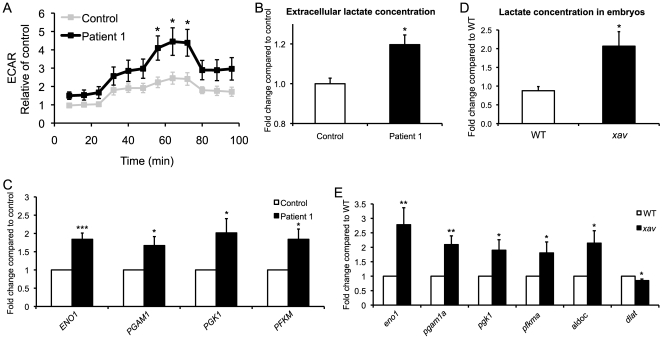
Increased aerobic glycolysis in MADD fibroblasts and xav mutants.
A. ECAR was measured in intact control and MADD Patient 1 fibroblasts under basal conditions, following the addition of the mitochondrial inhibitor oligomycin (0.5 µg/ml), in the presence of the uncoupler CICCP (3 µM) and following the addition of the complex I inhibitor rotenone (100 nM). A trend towards higher ECAR rate was seen under basal conditions, and a significant 2-fold increase was observed after uncoupler CICCP treatment in Patient 1 fibroblasts compared to control. (N = 3 experiments, 7–9 replicates of cells from passage 7–12; Student's t test, * p<0.05). B. Lactate present in the culture medium showed a ∼20% increase in the basal lactate production in Patient 1 fibroblasts compared to control (N = 2 experiments, 5–6 replicates of cells from passage 7–8; Student's t test, * p<0.05). C. qRT-PCR analyses of genes involved in glycolysis showed glycolytic enzymes enolase 1 (ENO1), phosphoglycerate mutase 1 (PGAM1), phosphoglycerate kinase 1 (PGK1) and phosphofructokinase (PFKM), were increased by ∼1.9, 2.7, 3.4 and 3.1 fold respectively in Patient 1 fibroblasts compared to control (N = 5 replicates of cells from passage 7–9; Student's t test, * p<0.05, *** p<0.001). D. Lactate levels showed a ∼2.4 fold increase in xav mutants compared to WT embryos at ∼56 hpf (N = 7–9 replicates, 30–100 embryos each; Student's t test, * p<0.05). E. qRT-PCR analyses of gene expression revealed increased expression of glycolytic enzymes eno1, pgam1a, pgk1, pfkma, and fructose-biphosphate aldolase C (aldoc) by 2.8, 2, 1.9, 1.8 and 2.1 fold respectively, as well a ∼20% decrease in dihydrolipoamide S-acetyltransferase (dlat), that belongs to the pyruvate dehydrogenase complex, which links glycolysis to tricarboxylic acid (TCA) cycle, in xav mutants compared to WT embryos at ∼56 hpf (N = 3–7 replicates, 20 embryos each; Student's t test, * p<0.05, ** p<0.01).